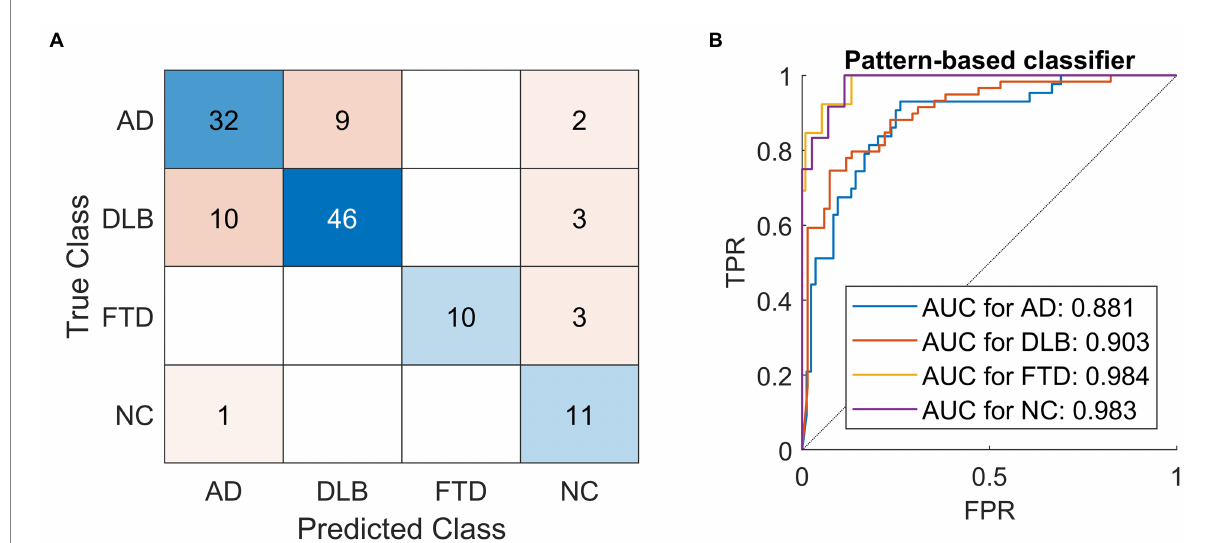
FIGURE 3 The classification results using a pattern-based support vector machine classifier. A classifier based on pattern expression values and multi-class support vector machine (SVM) correctly diagnosed 99 out of 127 cases and achieved 78% overall accuracy. (A) Confusion matrix of labels predicted by the SVM (Predicted Class) compared to gold standard (True Class). (B) One vs. all receiver operating characteristic (ROC) curves for the four possible labels. AD, dementia due to Alzheimer’s disease; DLB, dementia with Lewy bodies; FTD, frontotemporal dementia; NC, normal control; AUC, area under the curve; TPR, true positive rate; FPR, false positive rate.